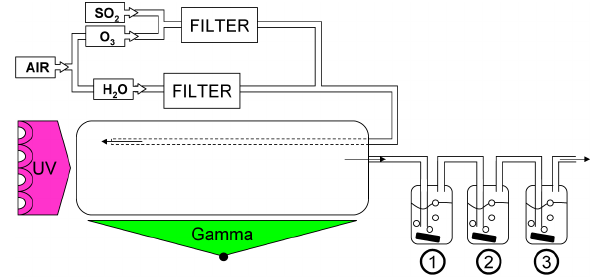
Fig. 1. Schematic of the chamber setup in Copenhagen. The purified airstream is split in two, one passing through the humidifier and the other through the ozone generator before rejoining along with the SO 2 flow and entering the chamber (see text). The airstream leav- ing the reaction volume is passed through 3 numbered gas washing bottles, in series, with magnetic stirrers. Collimated UV light en- ters through a Teflon foil at the end of the chamber, while a gamma source is place at the